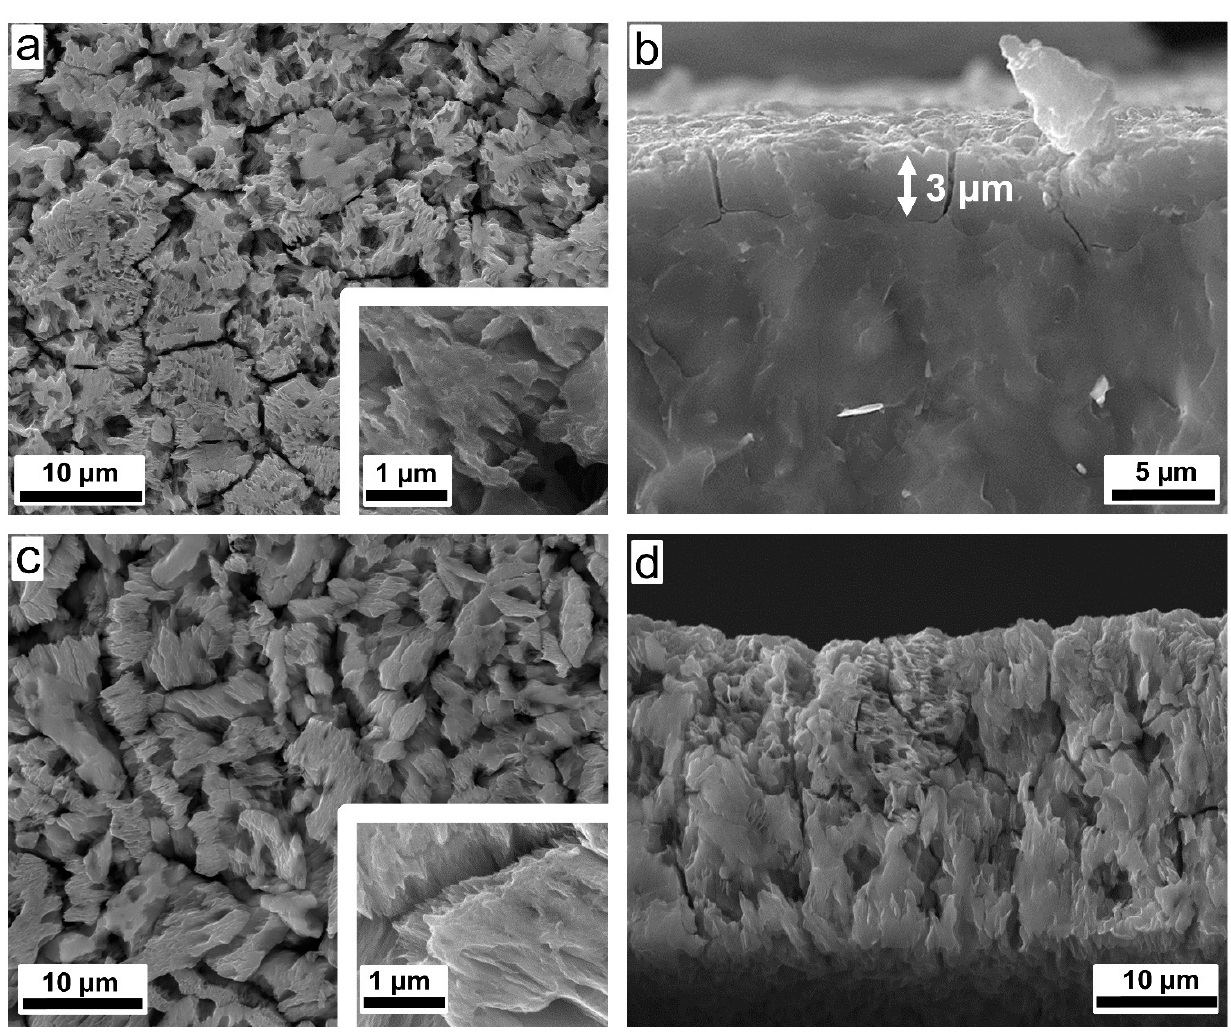
Figure 8. SEM images (on the left—surface view; on the right—cross-sectional view) of ( a , b ) DS_1h and ( c , d ) DS_3h.